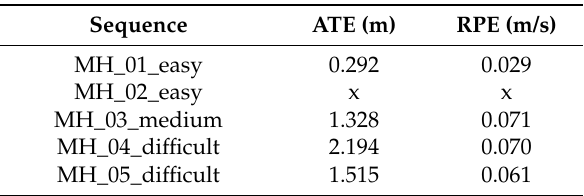
Table 5. RMSE values of ATE and RPE on EuRoC datasets using rotational-invariant oriented fast and rotated brief (ORB)